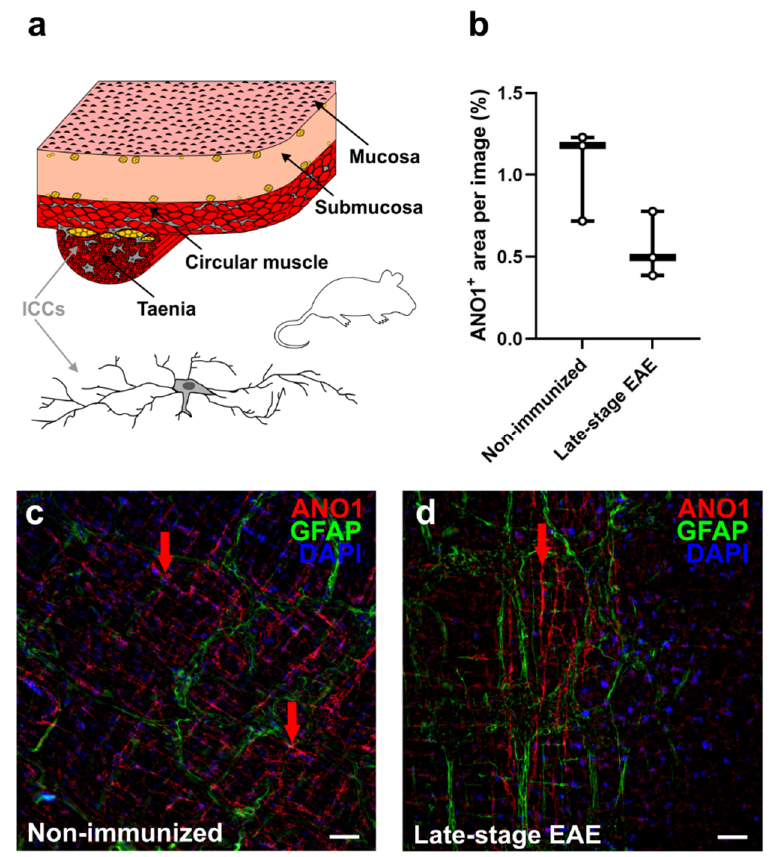
Figure 3. Immunohistological staining of murine myenteric plexus (MP). Whole mounts were obtained from the colons of female C57BL/6J mice with late-stage experimental autoimmune encephalomyelitis (EAE) ( n = 3) or from a non-immunized control group (CTRL) ( n = 3). For analysis of anoctamin 1 (ANO1), only tissue containing MP was included. The level of the MP was determined by co-staining of glial fibrillary acidic protein (GFAP). ( a ) Schematic representation of ICCs and their location within the gastrointestinal wall. ( b ) The percentage of the ANO1 + area per image was determined. Individual data points display mean values per mouse. The box and whisker plots show median values, together with the interquartile range. Statistical significance was determined by unpaired Student’s t test. ( c , d ) Representative single-optical sections derived from z-stacks (z-steps: 2.4 µm) with positive ANO1 staining ( red arrows ) were selected from ( c ) a non-immunized CTRL and ( d ) a mouse with late-stage EAE. For each mouse, six images from different locations were analyzed. Scale bars denote 50 µm.